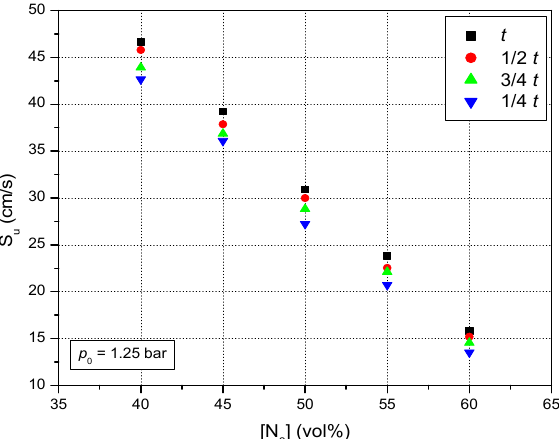
Figure 8. Variation of laminar burning velocities with diluent concentration for stoichiometric CH 4 -N 2 O mixtures diluted with N 2 , at p 0 = 1.25 bar and ambient initial temperature. CH 4 -N 2 O mixtures diluted with N 2 , at p 0 = 1.25 bar and ambient initial